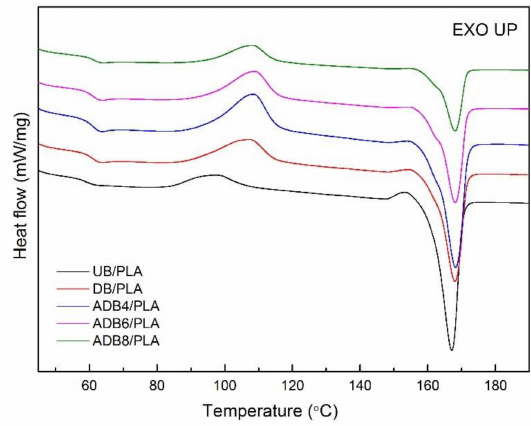
Figure 4. DSC curves of various treatments of effect on thermal properties of BF/PLA composites.